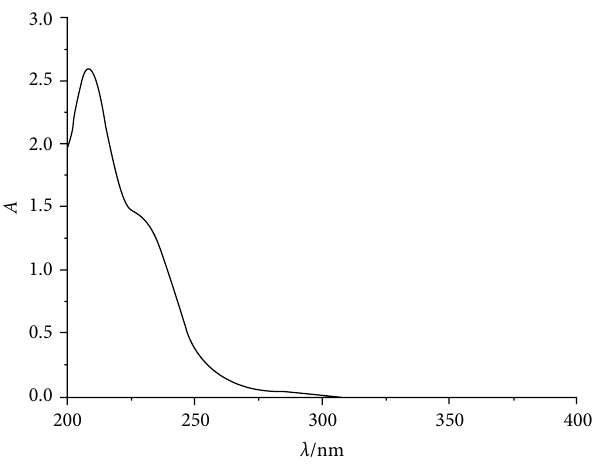
Figure 3: UV absorption spectrum of NiZrMo.